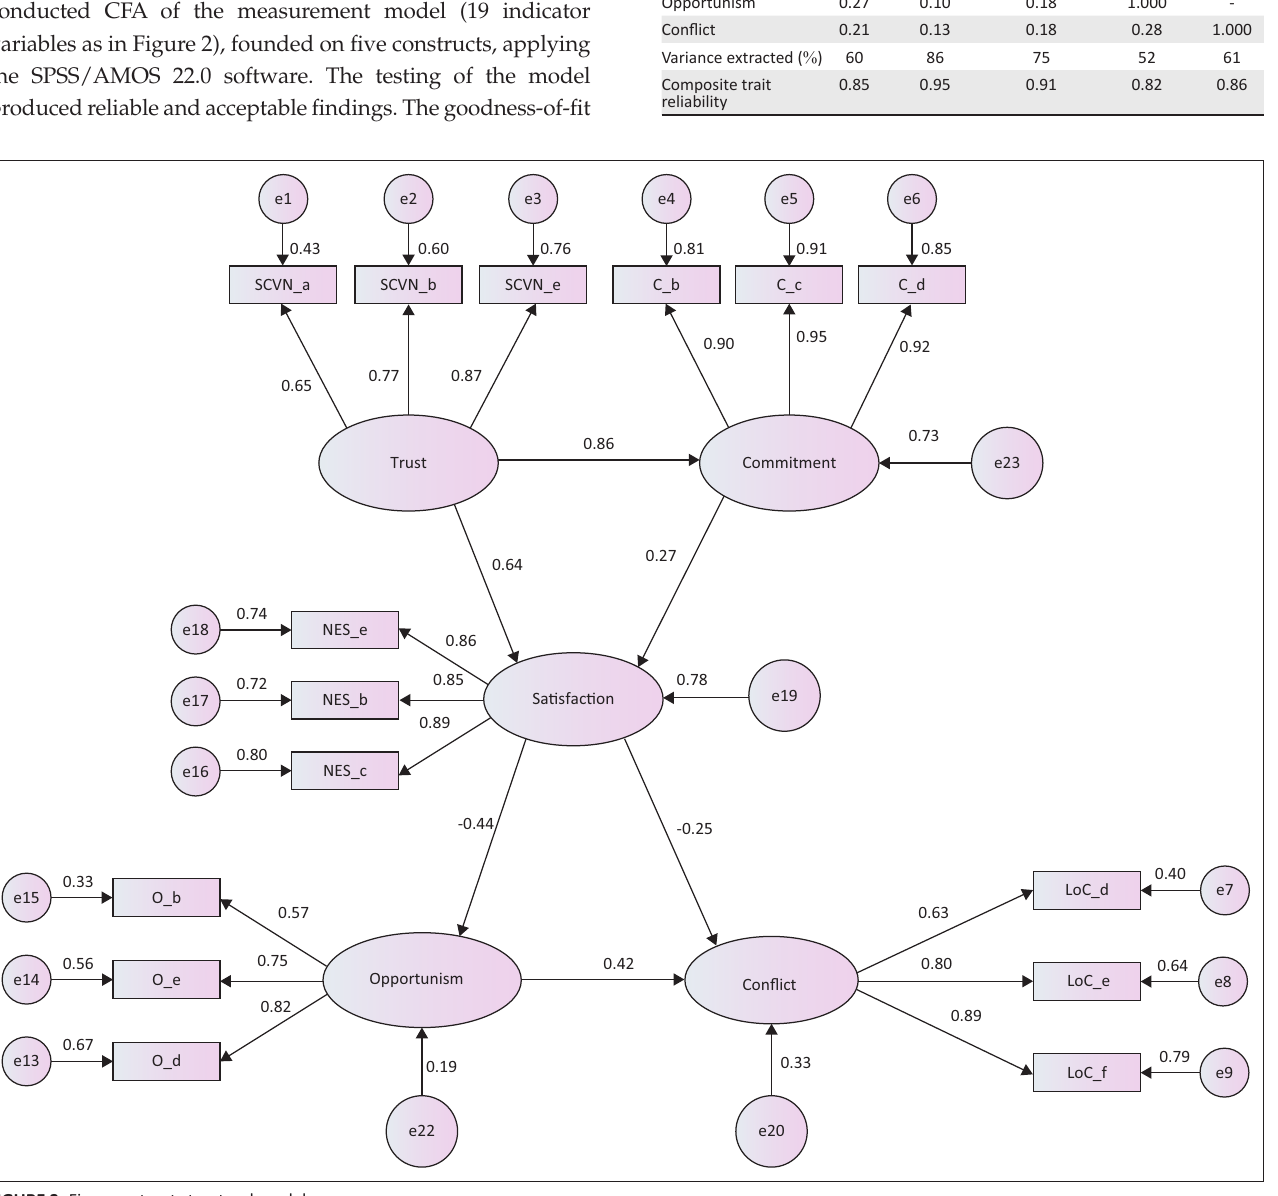
FIGURE 2: Five-construct structural